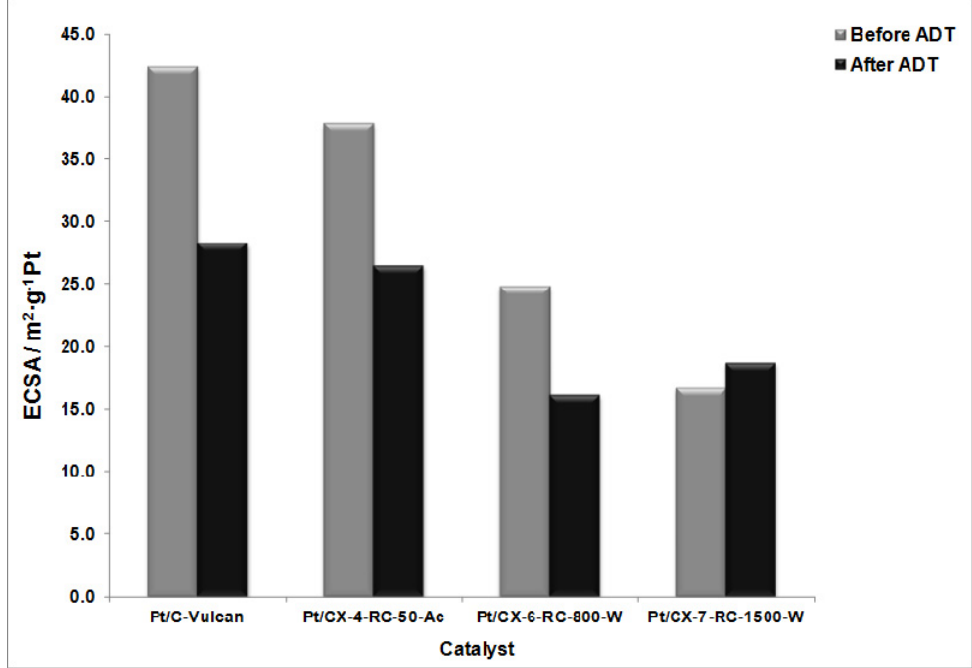
Figure 9. Electrochemically active surface area (ECSA) before and after accelerated degradation tests